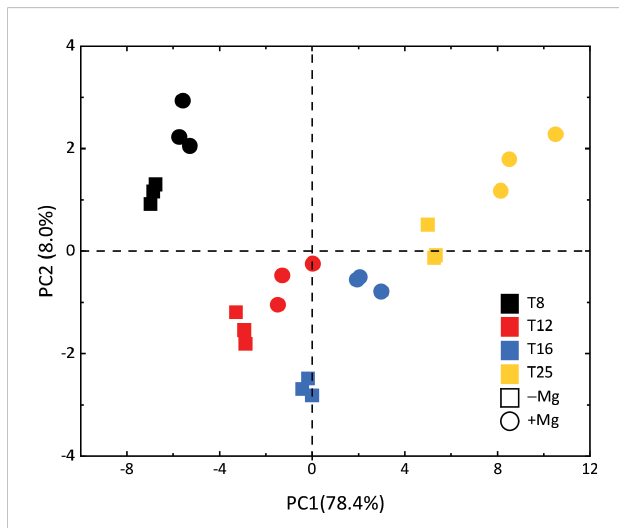
FIGURE 10 The principal component analysis (PCA) clustered the input variables of temperature and Mg into different